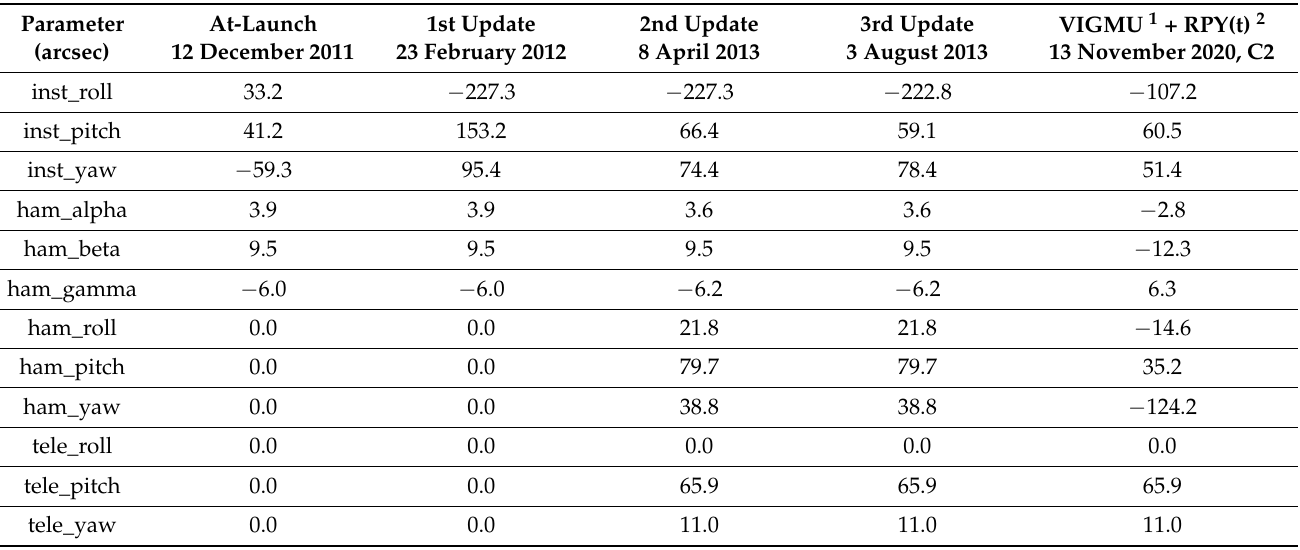
Table 1. List of major SNPP VIIRS geolocation parameter updates.